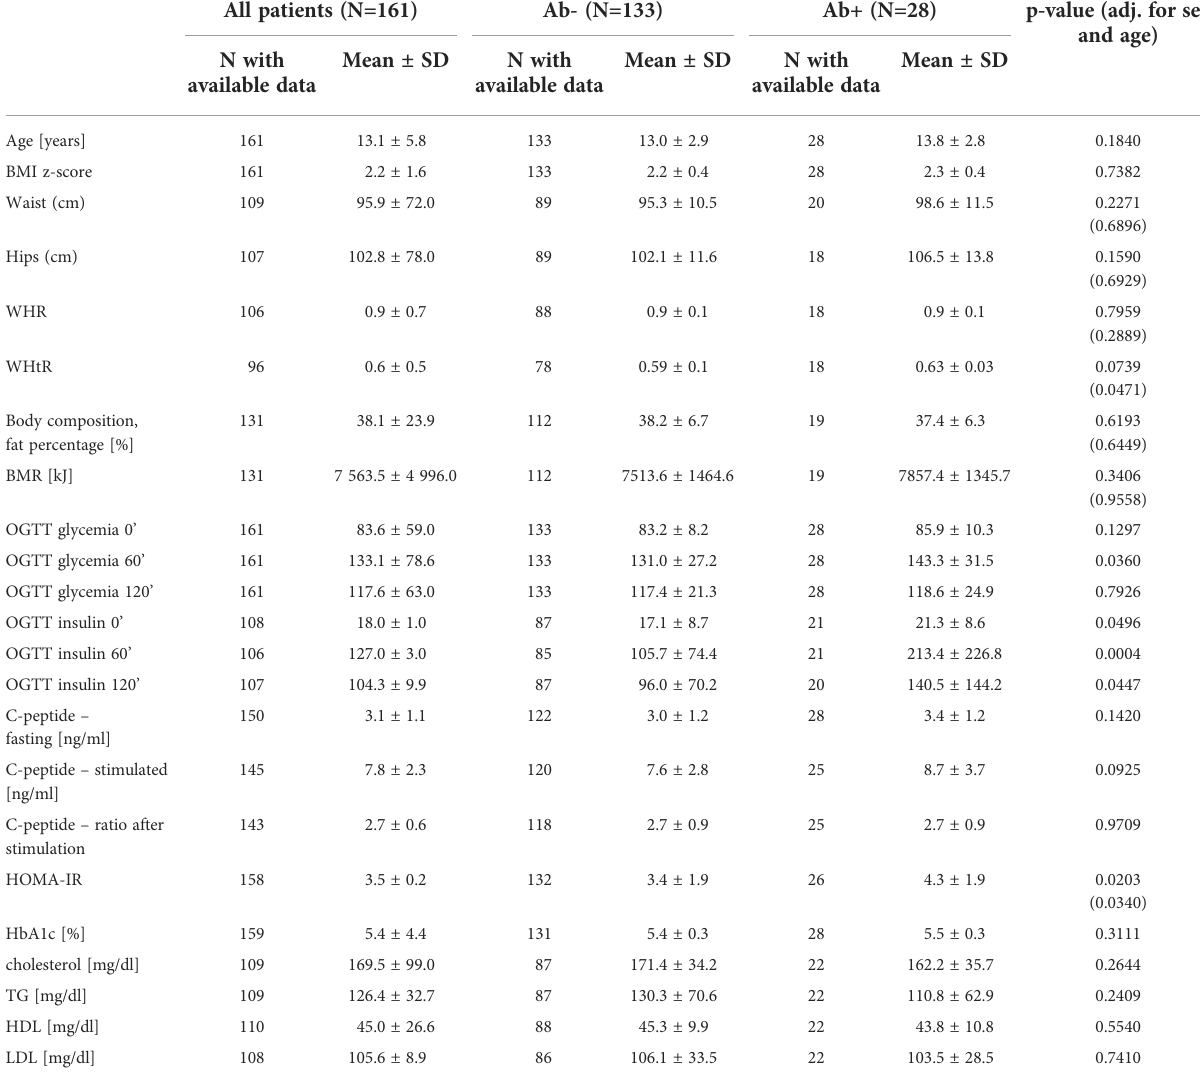
TABLE 1 Clinical and biochemical characteristics of obese children and adolescents according to the presence of beta cell autoantibodies. All patients (N=161) Ab- (N=133) Ab+ (N=28) p-value (adj. for sex and age) N with Mean ± SD N with Mean ± SD N with Mean ± available data available data available data